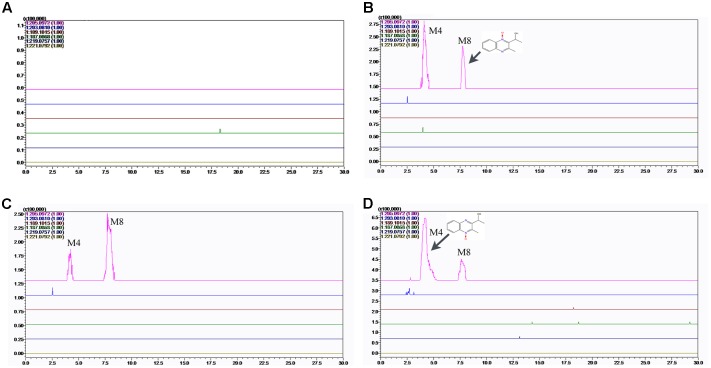
Accurate EIC of MEQ and metabolites of MEQ in the serum of male mice. (A) Serum of control. (B) Serum of 25 mg/kg MEQ. (C) Serum of 55 mg/kg MEQ. (D) Serum of 110 mg/kg MEQ.